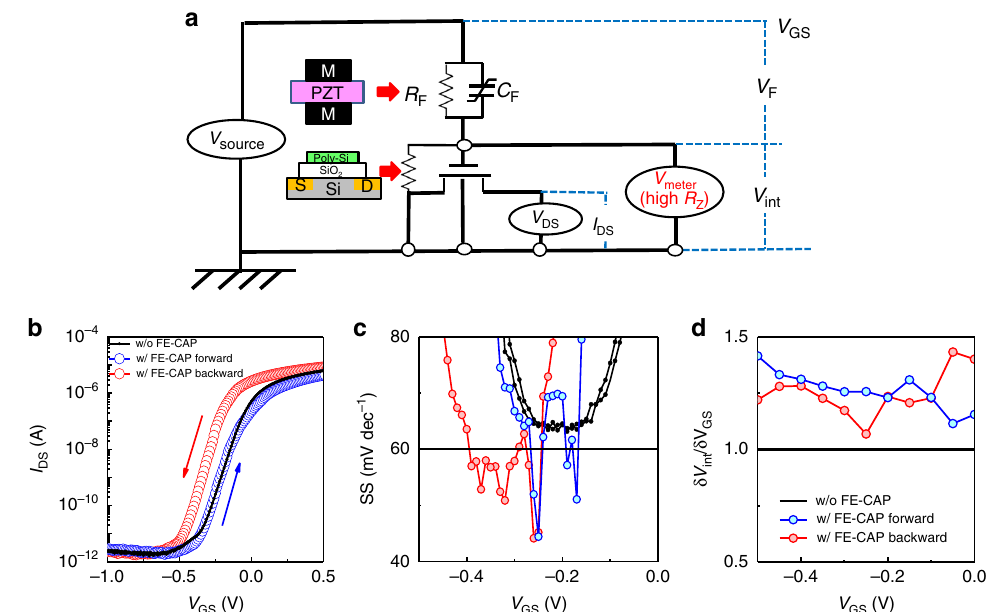
Fig. 3 Correlation of V int gain with steep SS in FET. a Equivalent circuit for measuring I DS -V GS and V int -V GS characteristics in FE/MOSFET system. Note that V int -V GS and I DS -V GS were measured separately for the same system and under the same V DS (0.1 V). b I DS - V GS , c SS - V GS and d δ V int / δ V GS - V GS characteristics of MOSFET w/ and w/o external FE-CAP during sweepings of V GS . A correlation between sub-60 mV dec − 1 SS and internal potential gain is